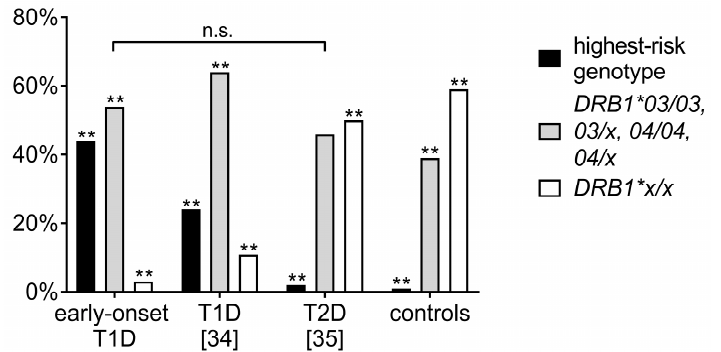
Figure 2. Comparison of the prevalence of Human Leukocyte Antigen (HLA) DR risk-groups in the patients with early-onset diabetes before age five years ( n = 233), and prior analyses of adolescent-onset T1D ( n = 1445; data from [34]) and type 2 diabetes (T2D) patients ( n = 109, data from [35]) with a local control population ( n = 19,544, each ** p < 0.001).